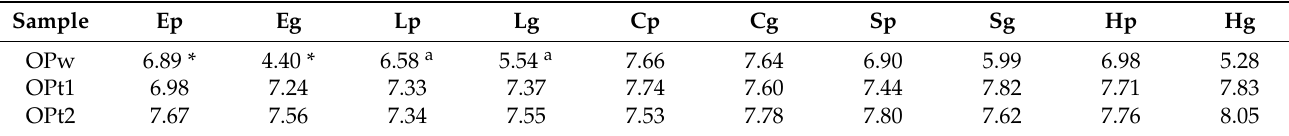
Table 3. Mean OP values of samples after water immersion, before thermocycling (w), after thermo- cycling for 5000 cycles (t1) and after thermocycling for 10,000 cycles (t2). * ,a significant changes after hydrothermal aging.